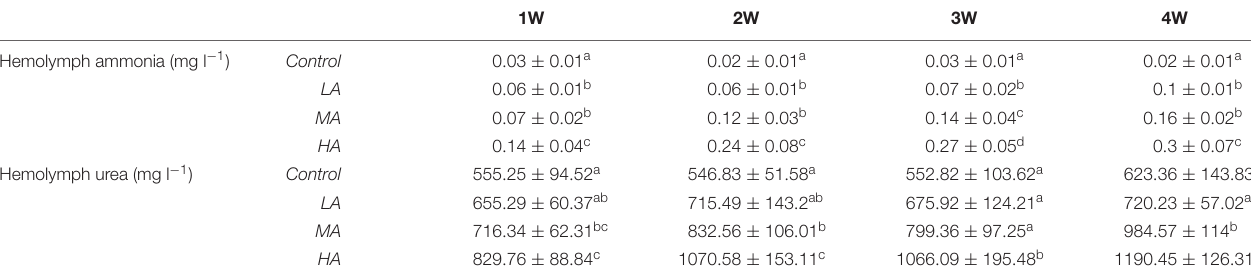
TABLE 3 | Hemolymph ammonia and urea contents in different groups during long-term ammonia stress.